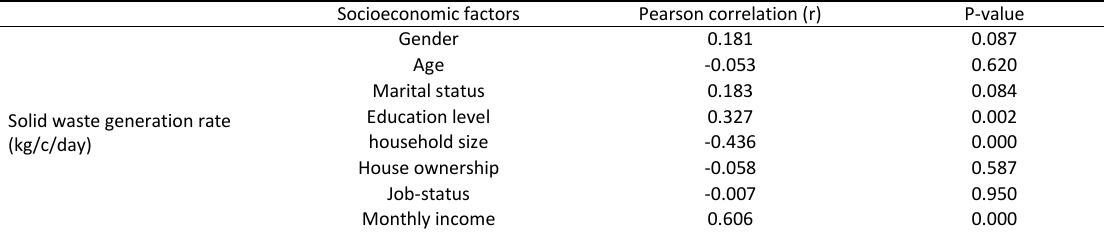
Municipal solid wastes modeling Table 4: Relation between HSWG rate and socioeconomic factors Table 4: Relation between HSWG rate and socioeconomic Socioeconomic factors Pearson correlation (r)